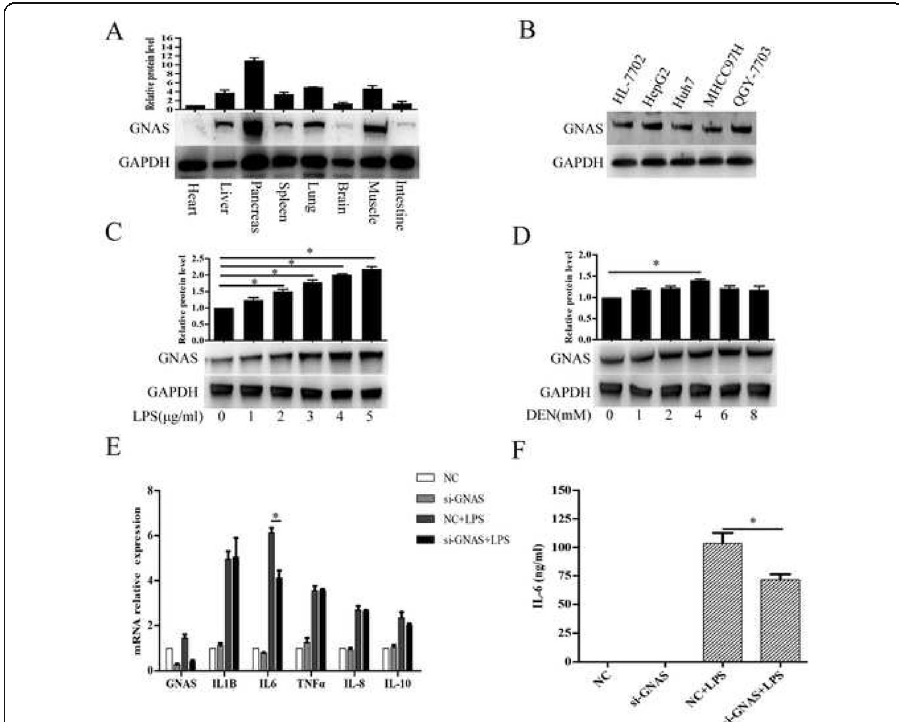
Fig. 1 LPS stimulation promotes GNAS expression in HCC cells, and GNAS knockdown inhibits LPS-induced IL-6 expression. a GNAS protein expression levels in different tissues were detected by Western blotting. b GNAS protein expression levels in the indicated HCC cell lines and HL-7702 human normal liver cells were detected by Western blotting. c and d HepG2 cells were treated with the indicated LPS ( c ) or DEN ( d ) for 12 h, and then GNAS protein expression levels were detected by Western blotting. e and f HepG2 cells were transfected with si-NC or si-GNAS for 24 h and then treated with LPS (5 μ g/ml) for 12 h. The relative expression levels of the indicated mRNAs were analyzed by qRT-PCR ( e ). The expression levels of IL-6 in the culture supernatants were measured by ELISA ( f ). Data are represented as means ± SD ( n = 3; * represents P <